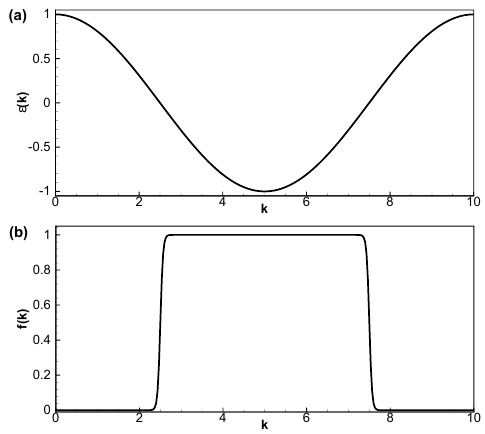
Figure 1. ( a ) Diagram of the used energy dispersion relation in the first Brillouin zone. ( b ) Example of momentum-resolved population at thermal